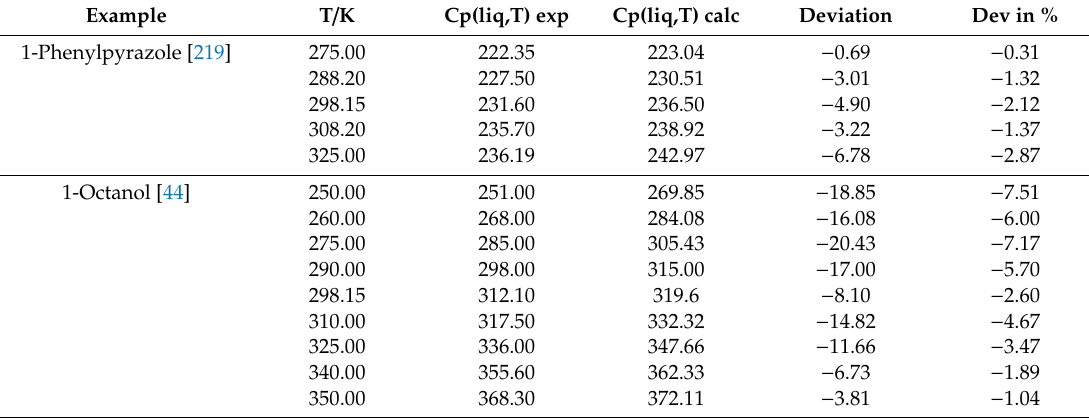
Table 19. Experimental and calculated liquid heat capacities of two compound samples at various temperatures in J / mol / K. (Calculations based on parameters of Tables 15 and 16, respectively). Example T / K Cp(liq,T) exp Cp(liq,T) calc Deviation Dev in % 1-Phenylpyrazole [219] 275.00